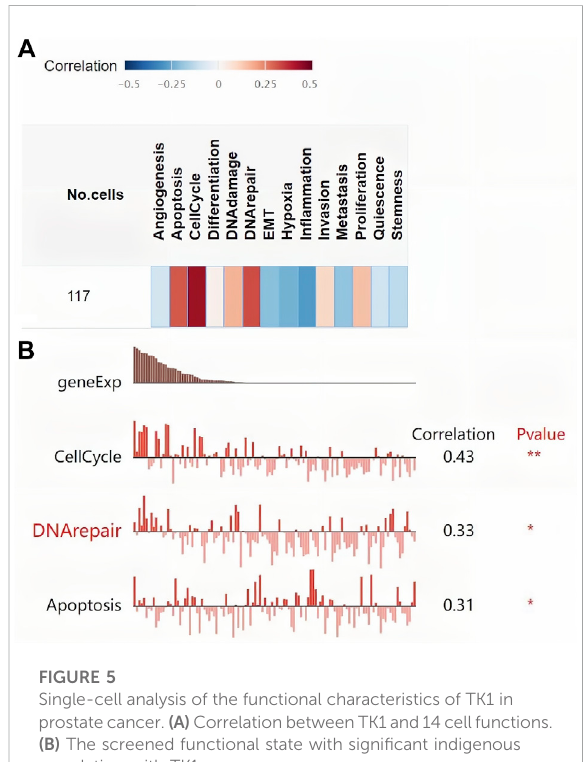
FIGURE 5 Single-cell analysis of the functional characteristics of TK1 in prostatecancer. (A) CorrelationbetweenTK1and14cellfunctions. (B) The screened functional state with signi fi cant indigenous correlation with